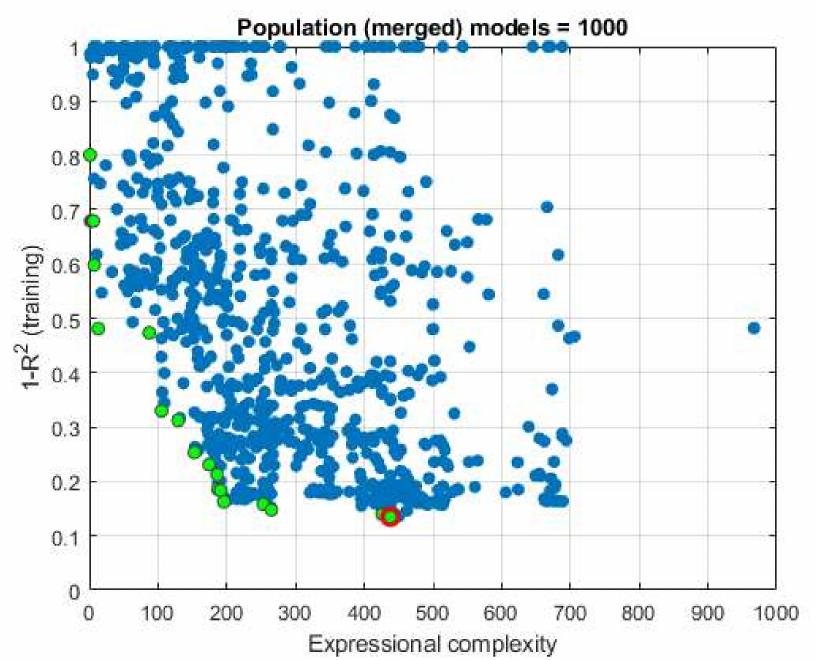
Figure 12. Display of models that make up the Pareto front marked with green circles, while the optimal model (Model ID 269) is marked with a red circle.